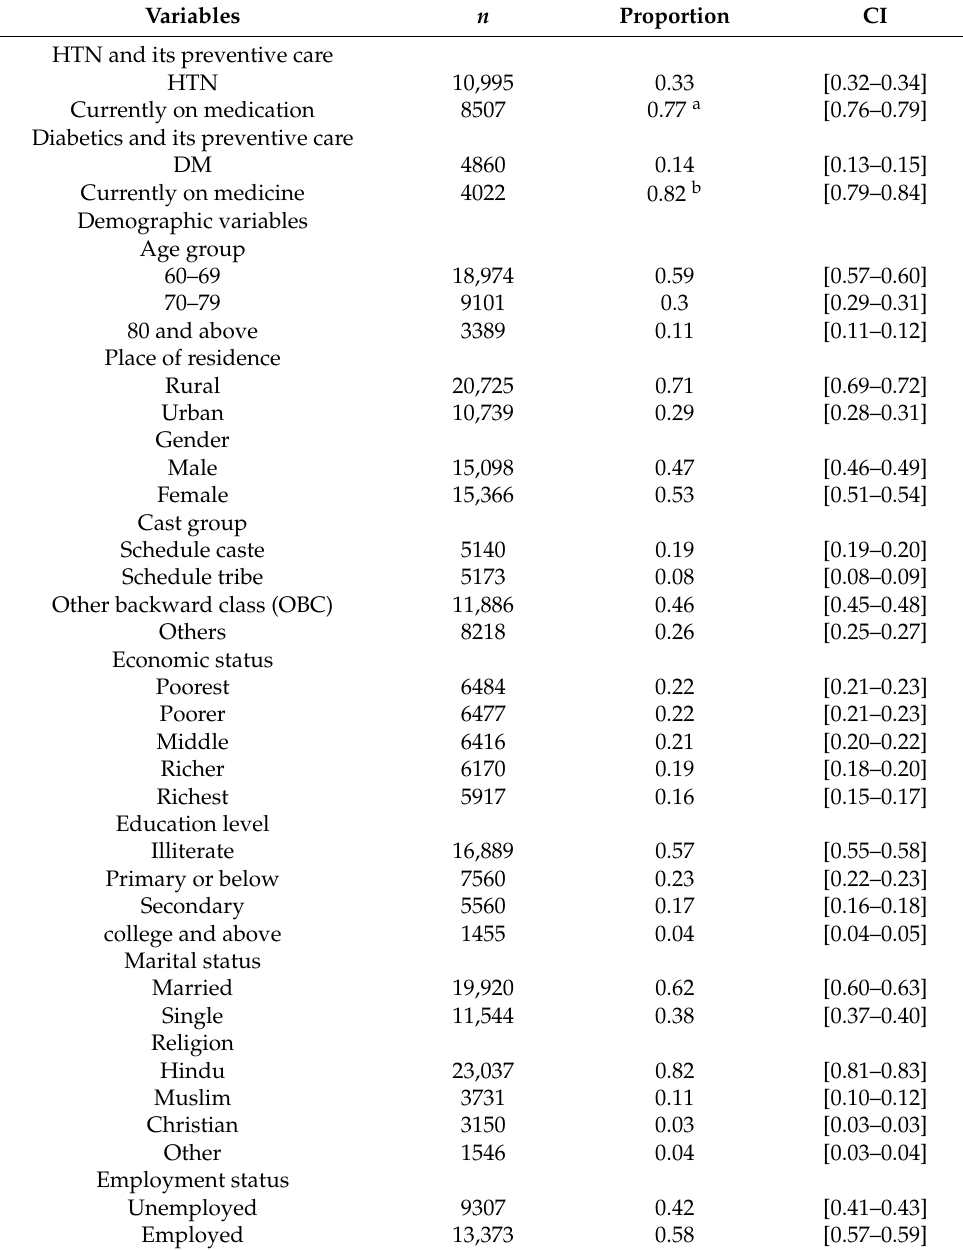
Table 1. Distribution of NCD and its prevention (treatment-seeking) among the respondents aged 60 years and